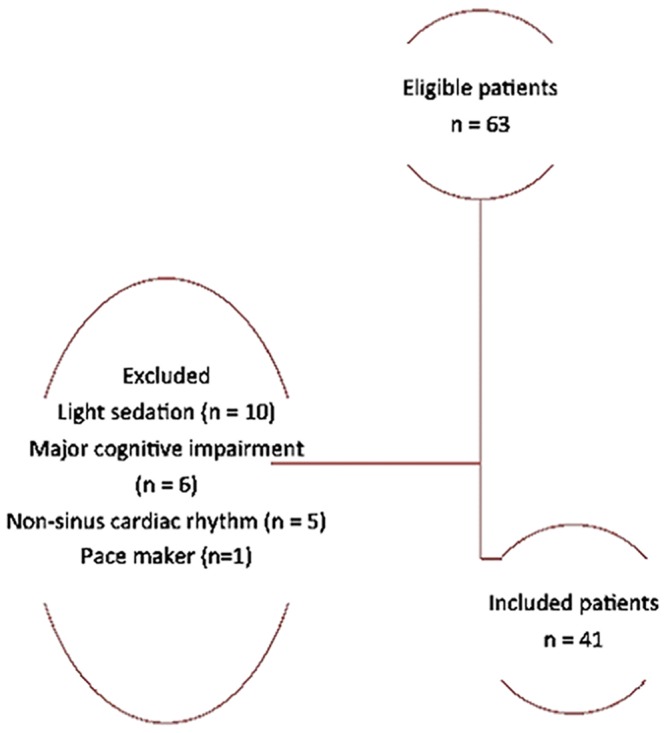
Study flowchart.